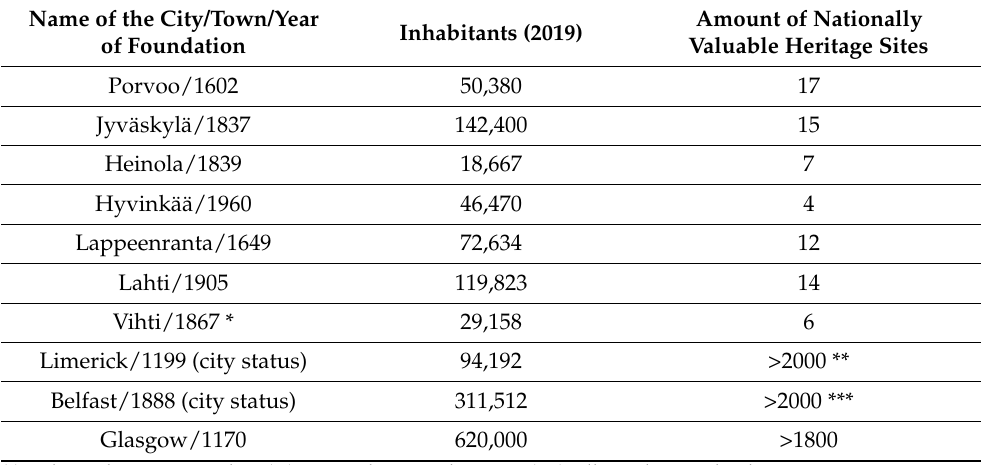
(environments) in their city area, and the results can be presented as follows. The population of each city is provided in the